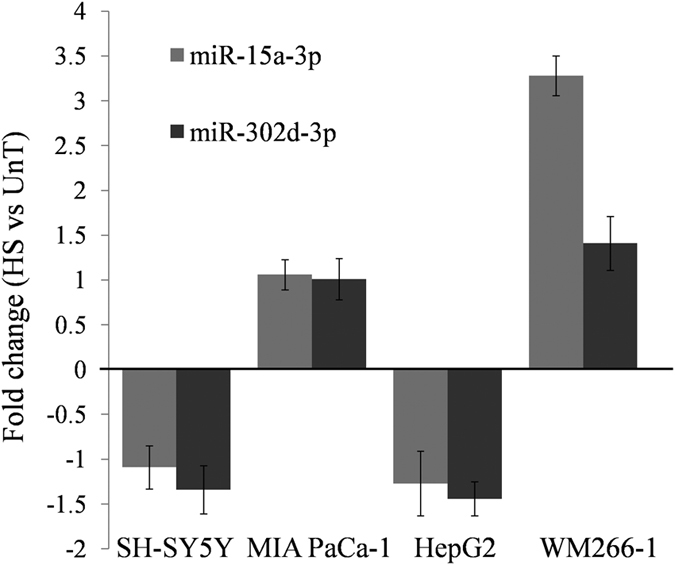
Tissue-specific expression of miRNAs during heat shock response.Both miR-302d-3p and miR-15a-3p were checked for their differential expression in response to heat shock, across four different cell lines belonging to skin (WM266-1), liver (HepG2), pancreas (MIA PaCa-1) and brain (SH-SY5Y). Of these, only the skin cell line (WM266-1) showed more than 3-fold up-regulation for miR-15a-3p, reinforcing the spatio-temporal expression of miRNAs. All the experiments were done in triplicates and represented here with SD.